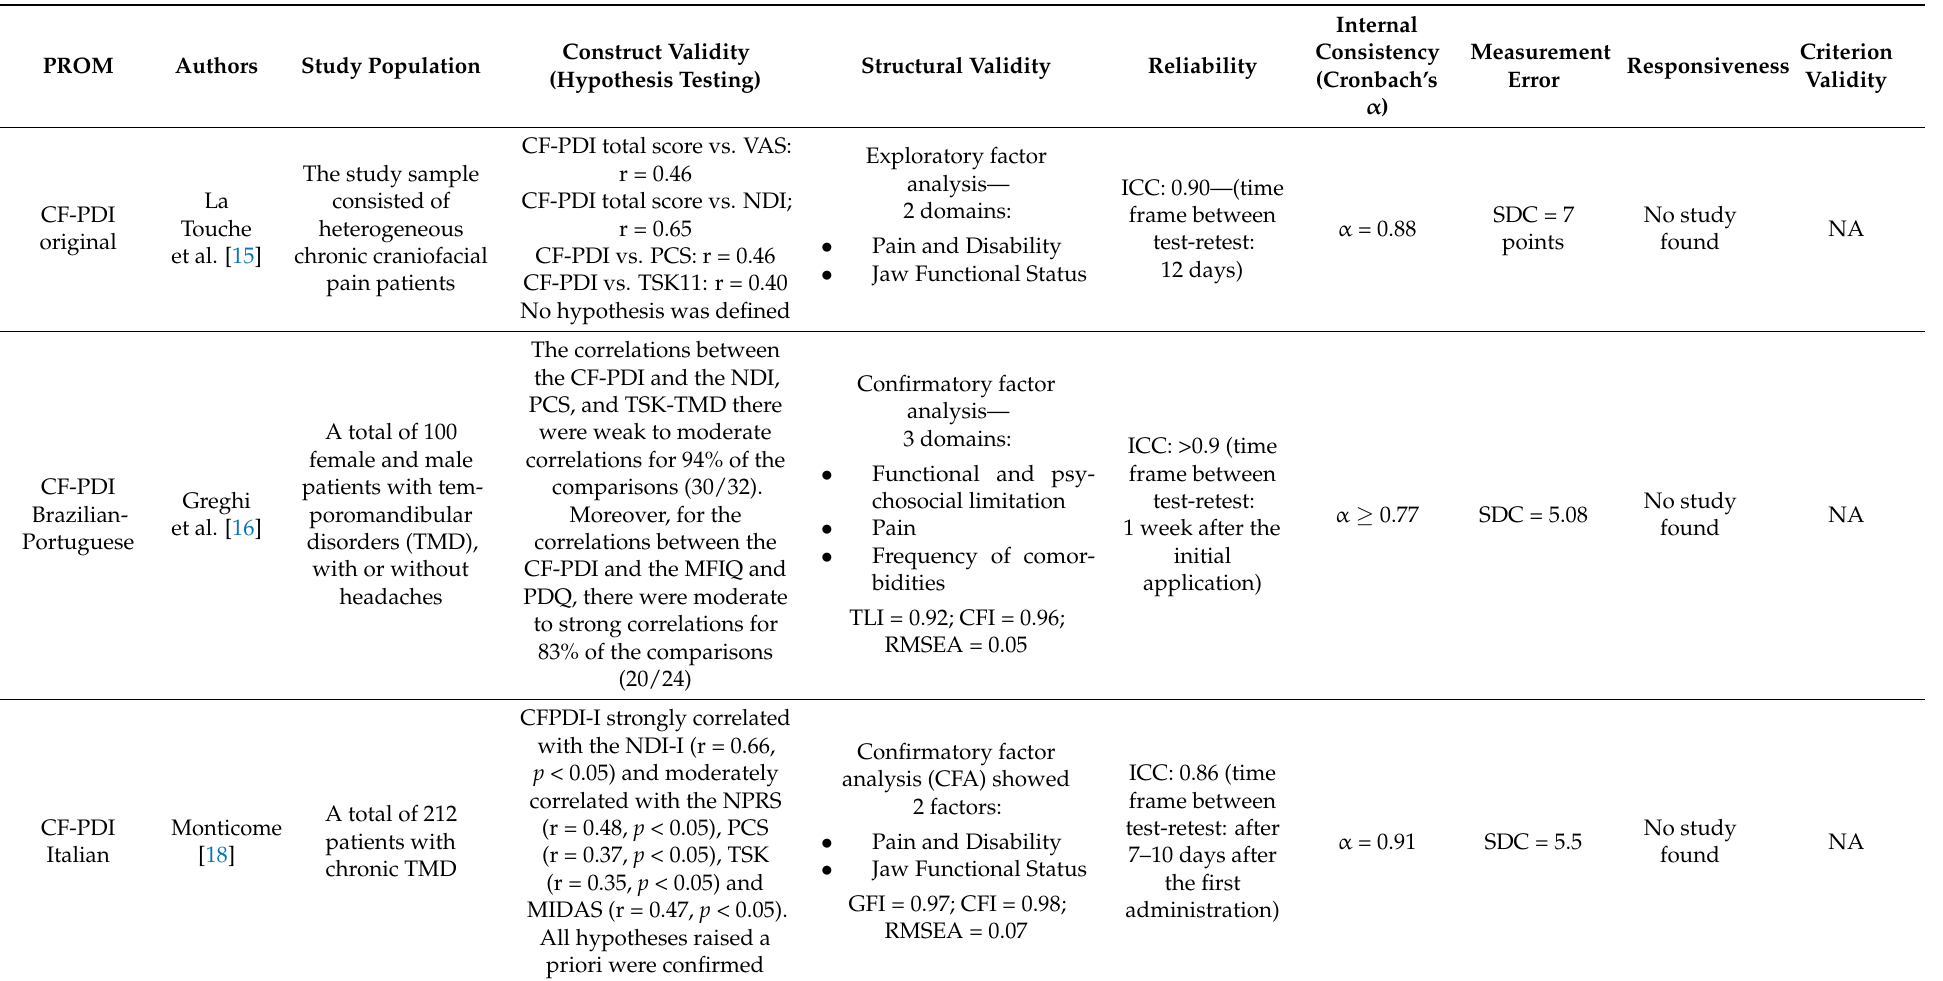
Table 2. Summary of the measurement properties Craniofacial Pain and Disability Inventory (CF-PDI)